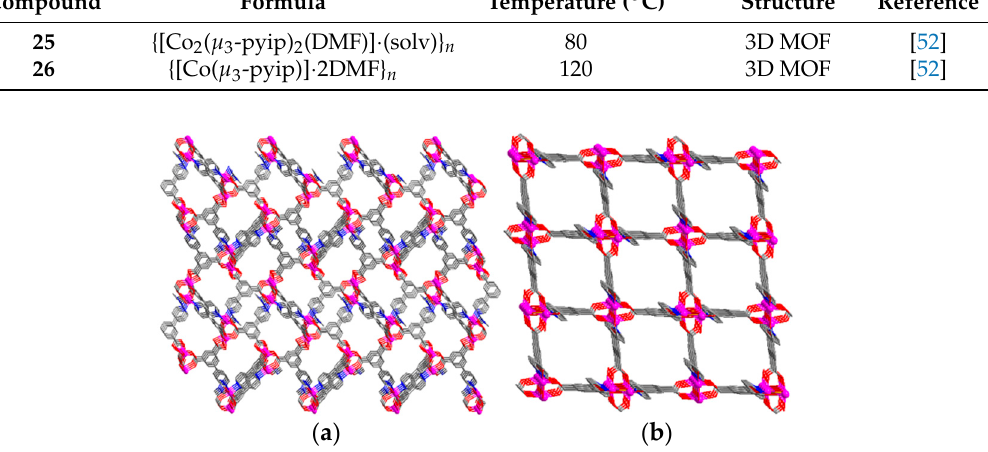
Figure 6. 3D metal-organic frameworks of 25 ( a ) and 26 ( b ). Adapted from [52].